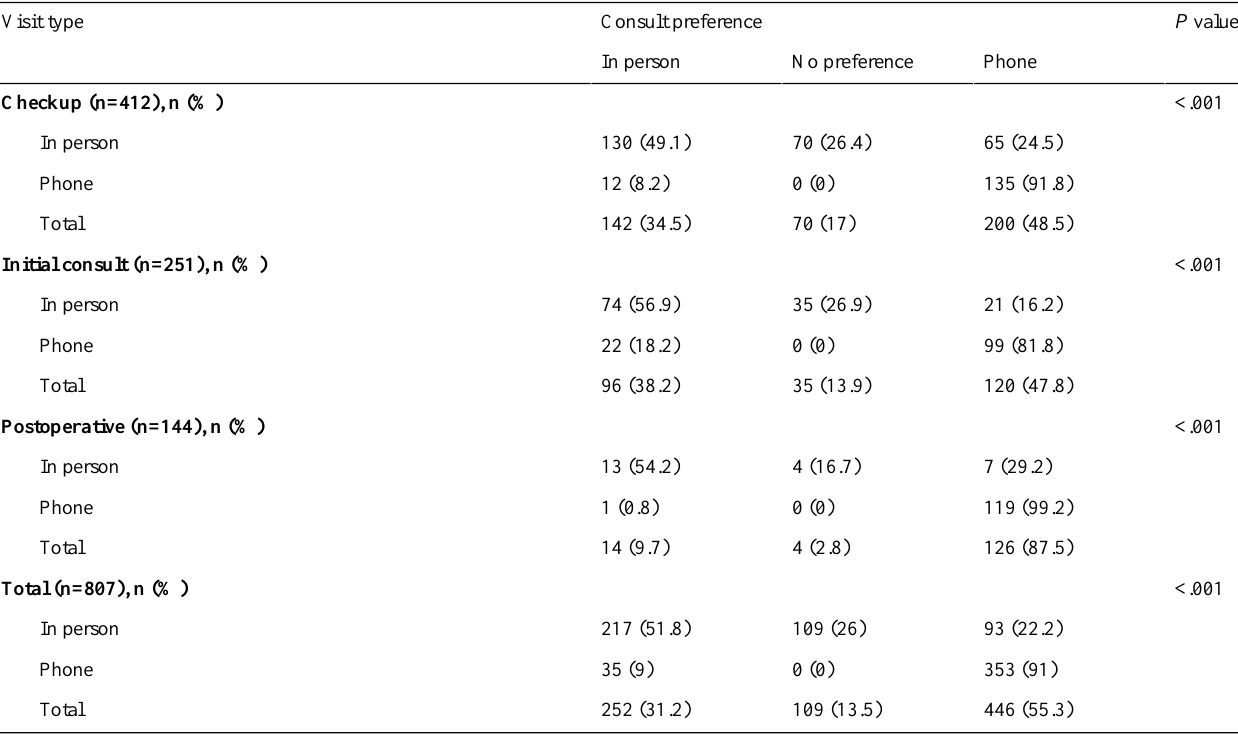
Table 1. Patient preference for consultation according to visit